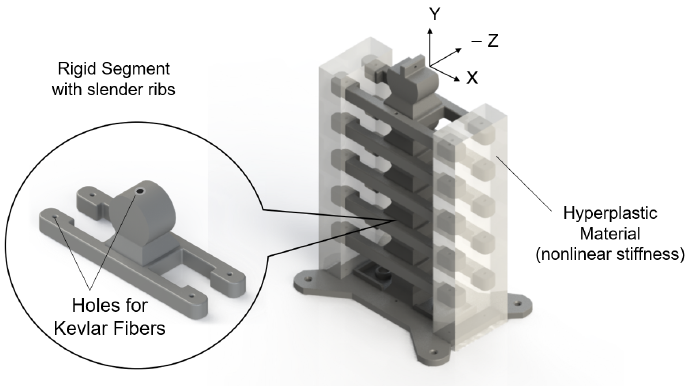
Figure 1. The snake-inspired musculoskeletal system consists of rigid segments (dark gray) connected with hyperelastic material (transparent sections) at the end of the ribs. Each rigid segment has a socket–disk joint and two ribs on each side. The hyperelastic material provided nonlinear elastic energy storage. The ribs transfer energy between the − X and X sides.